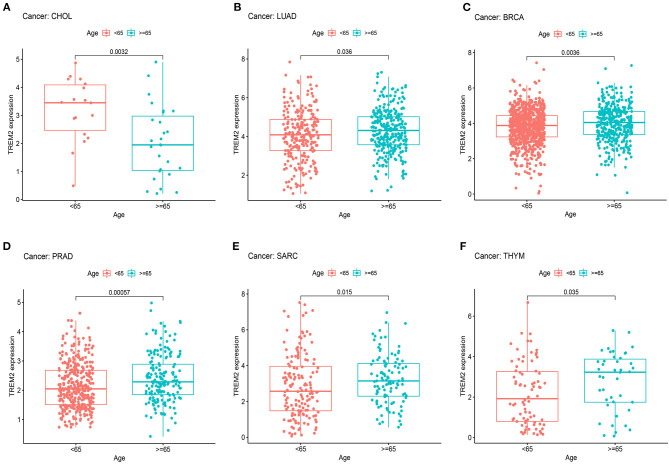
Association between TREM2 expression and age in (A) cholangiocarcinoma (CHOL), (B) lung adenocarcinoma (LUAD), (C) breast invasive carcinoma (BRCA), (D) prostate adenocarcinoma (PRAD), (E) sarcoma (SARC), and (F) thymoma (THYM).